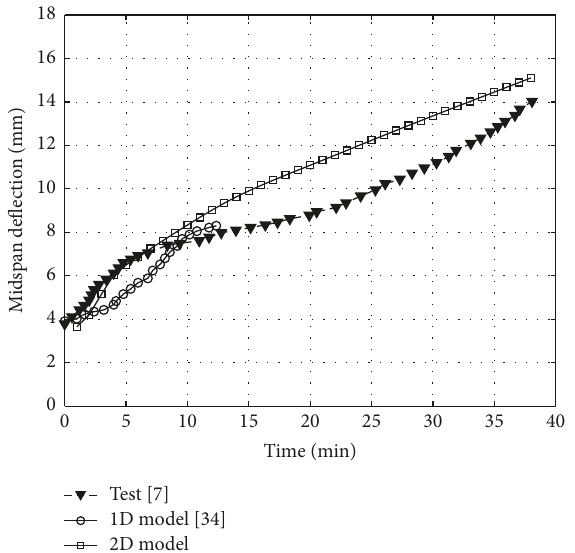
Figure 7: Comparison of mechanical responses of GFRP tube.